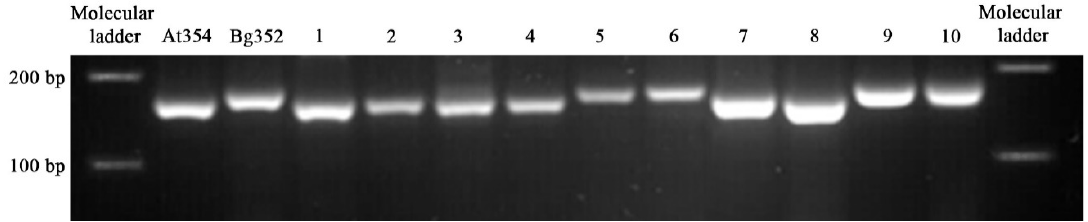
Figure 5. InDel marker for the identification of Polymorphism in Os01g0581400 . Lane (1). Pokkali-IRIS 313-8244, (2). Kurulutudu-IRIS 313-8925 (3).H6- IRIS 313-9472, (4).Puttu Nellu-IRIS 313-9969, (5).Honderawala-IRIS 313-11382, (6).Herath Banda-IRIS 313-11741, (7 to 10). RILs.3.